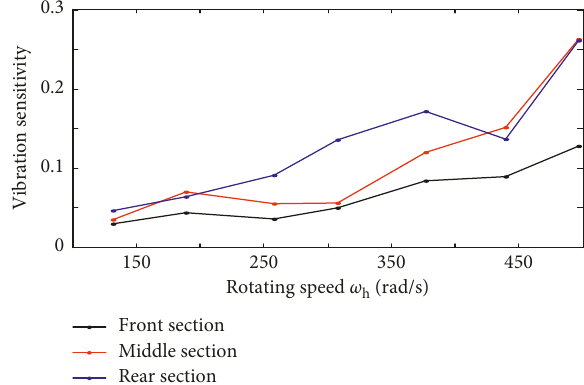
Figure 17: Experimental energy transmissibility η with varying rotating speed of high-pressure rotor ω h : front section (black), middle section (red), and rear section (blue).